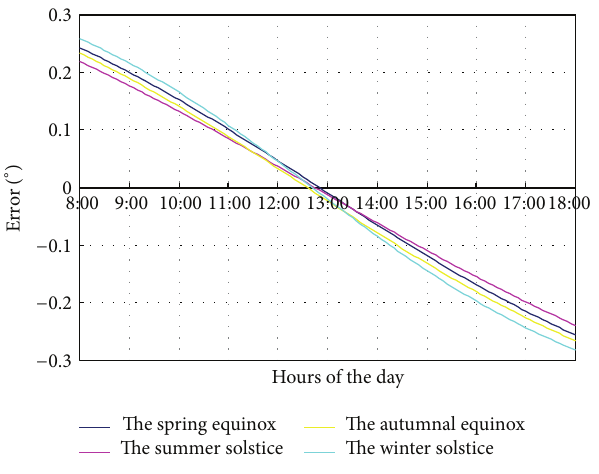
Figure 5: The tracking error on four typical days.